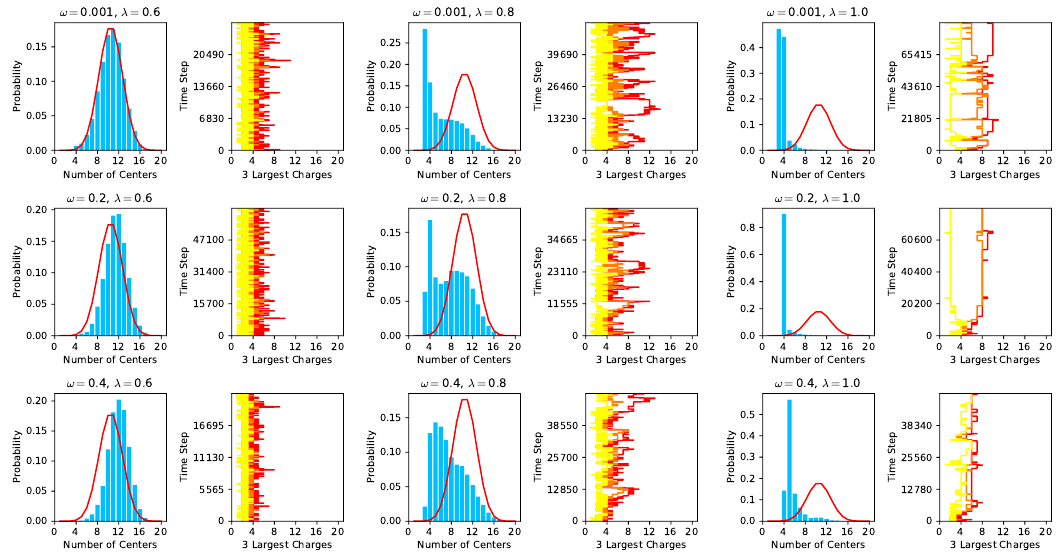
Figure 15: Random walk results for different values of ω and λ ; other parameters are fixed such that Q = 20, α = 1, β = 0, γ = 1, and δ =